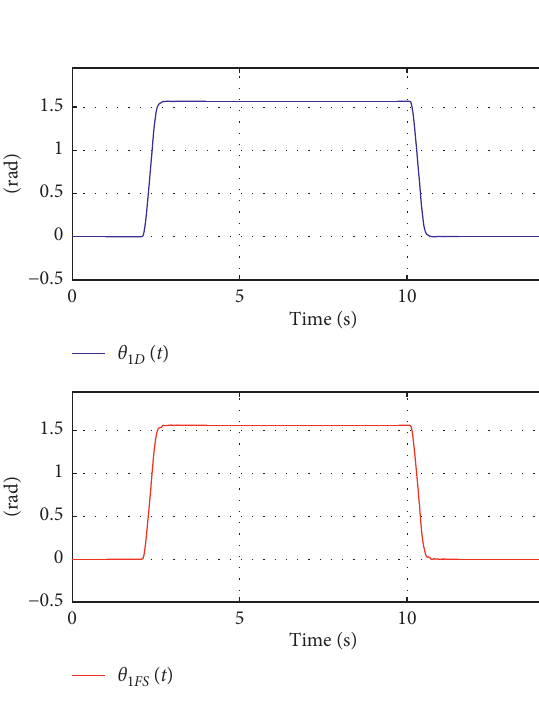
Figure 7: Tracking error.